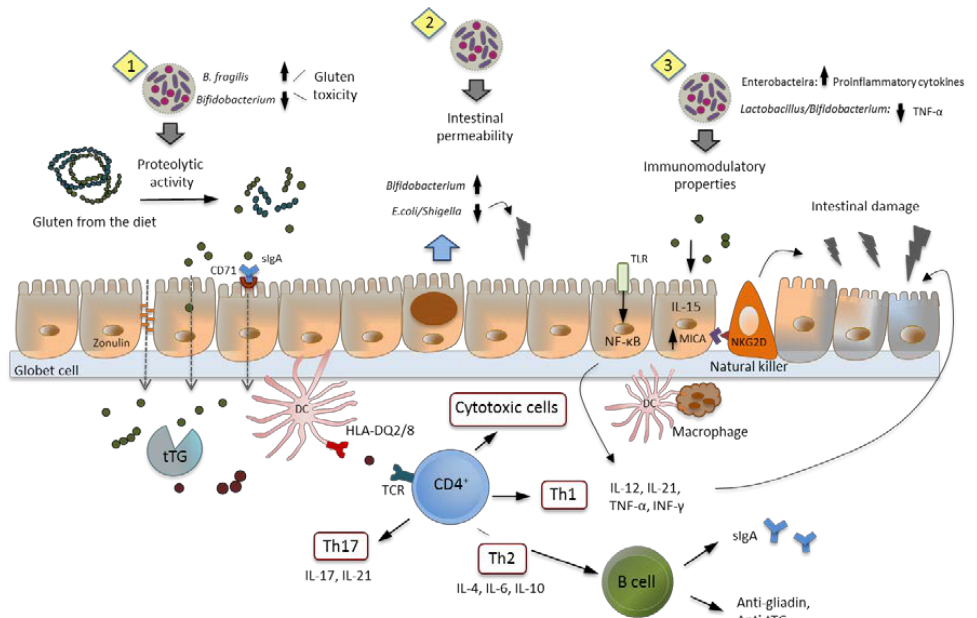
Figure 2. Potential mechanisms of action of intestinal microbiota components in